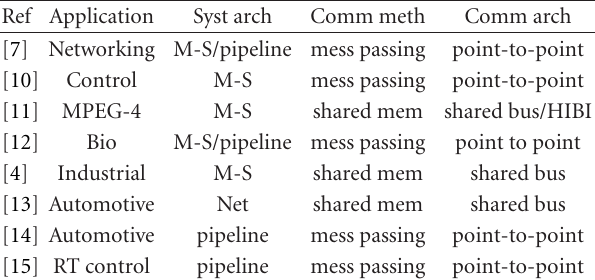
Figure 5: Distributed memory multiprocessor systems.